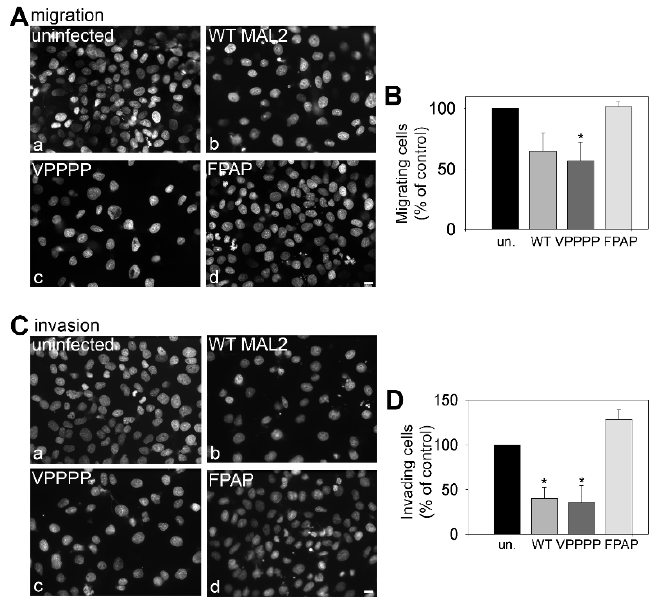
Figure 10. The FPAP motif mediates MAL2-induced protrusion formation and impaired cell migration. ( A – D ) Uninfected cells or cells expressing wild type of mutant MAL2 were seeded in serum-free medium onto filters in Boyden chambers in the absence (A,B) or presence of matrigel (C,D) cells. After 24 h, the nuclei of cells that had penetrated to the underside of the filter were labeled with DAPI and visualized (A,C). In (B,D), the numbers of MAL2-expressing cells that had penetrated the filter were determined relative to the numbers of uninfected cells and plotted as the percent of control (uninfected). In (B), * p ≤ 0.049 and in (D), p ≤ 0.007 for WT and ≤ 0.029 for VPPPP. Bar = 10 µm.